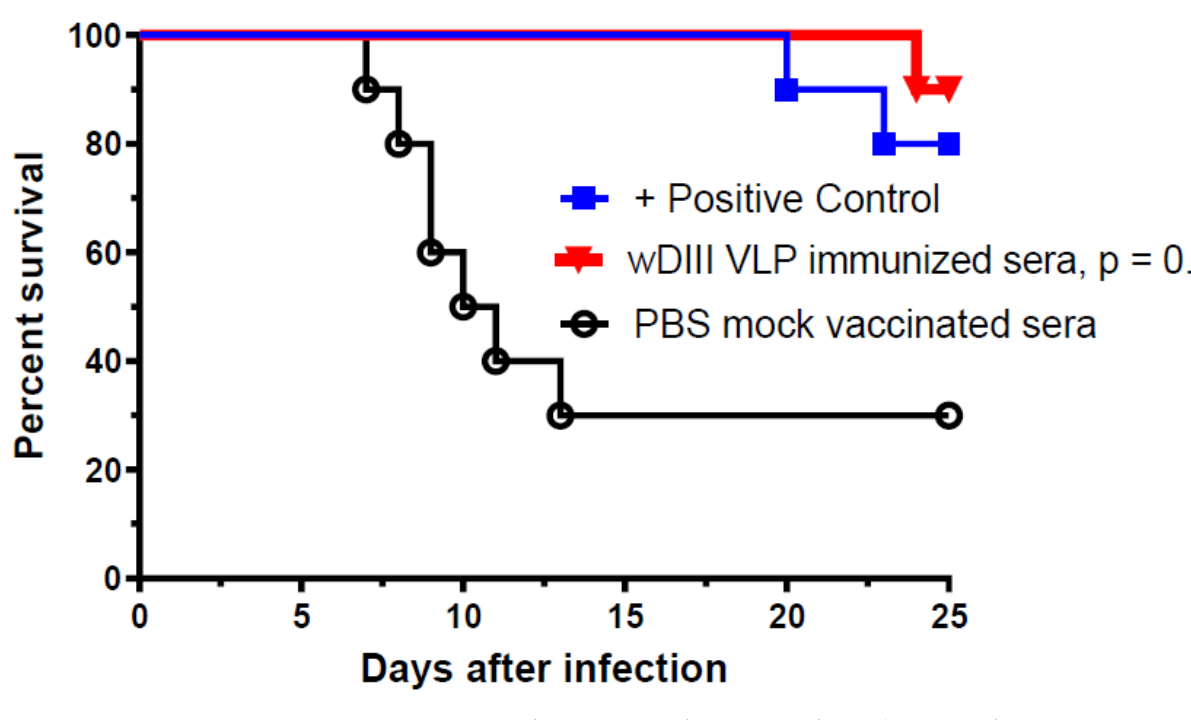
Figure 3. Protection of recipient mice from WNV infection by serum of HBcAg-wDIII VLP immunized mice. BALB/c mice were passively administered (r.o.) with 50 µL of heat inactivated serum collected from mice that were immunized with HBcAg-wDIII VLP (wDIII VLP) or mock-immunized with PBS. In the positive control group, 10 µg of a protective mAb was administered in place of serum. Mice were challenged with 10 2 PFU of WNV 1 h after receiving serum or mAb. Two inde-